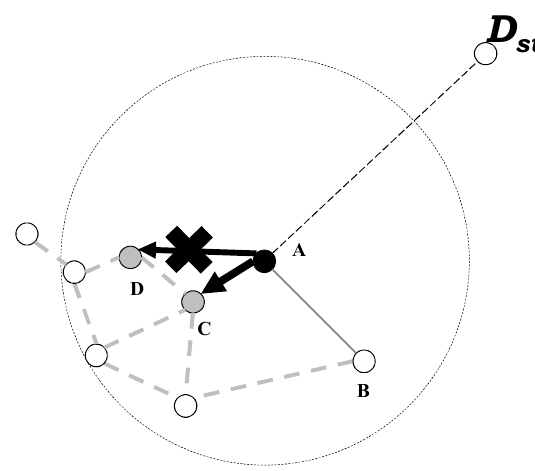
Figure 1. Face-routing limitation due to the generated local planar